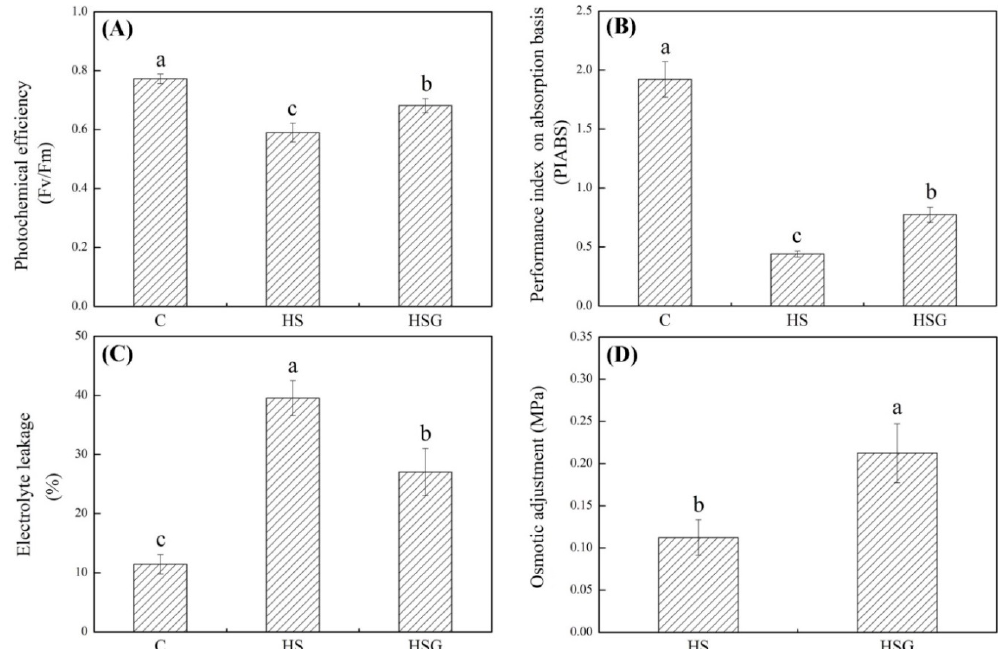
Figure 1. Effects of exogenous γ -aminobutyric acid (GABA) on ( A ) phenotypic changes and ( B ) endogenous GABA content in leaf of creeping bentgrass under heat stress. Vertical bars indicate ± SE of mean ( n = 4) and different letters above columns indicate significant differences ( p ≤ 0.05). C, control (normal condition); HS, heat stress; HSG, heat-stressed plants pretreated with GABA.